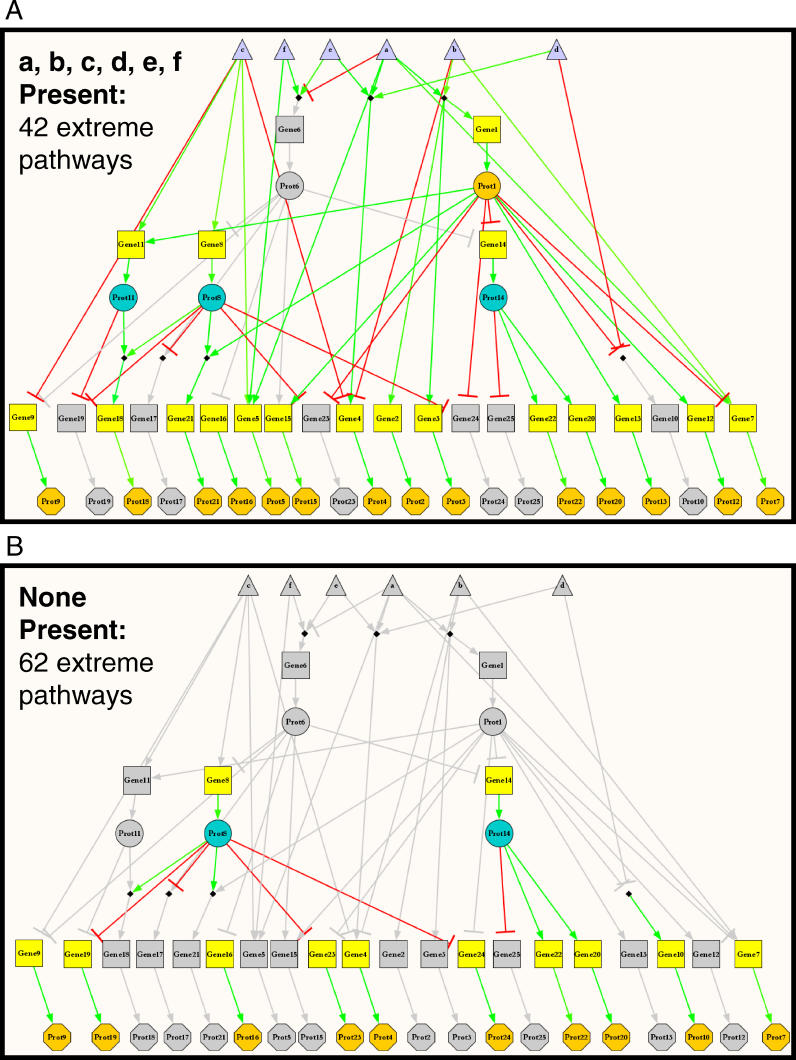
Expression States for the Prototypic TRS for the Environment in Which All Metabolites Are Present as well as the Environment in Which All Metabolites Are AbsentThe expression (i.e., functional) states for two different environments, as generated by extreme pathway analysis of R*, are presented.(A) The expression states for the environment in which all metabolites are present are shown. In this environment, a total of 42 extreme pathways exist leading to the activation or inactivation of the genes within the TRS.(B) The expression states for the environment in which all metabolites are absent are shown. In this environment, a total of 62 extreme pathways exist leading to the activation or inactivation of the genes within the TRS. As a legend, triangles represent extracellular cues, namely the six metabolites; squares represent the genes; and circles represent the protein products. Gray elements denote inactivity, whereas colored elements denote active components of the TRS for the given environment. Green arrows indicate that an upstream metabolite or transcription factor activates gene expression, whereas red lines indicate that the upstream metabolite or transcription factor inhibits gene expression. Lines that join together at dots denote “and” relationships within the Boolean regulatory rules, whereas lines that simply join together denote “or” relationships within the Boolean regulatory rules.